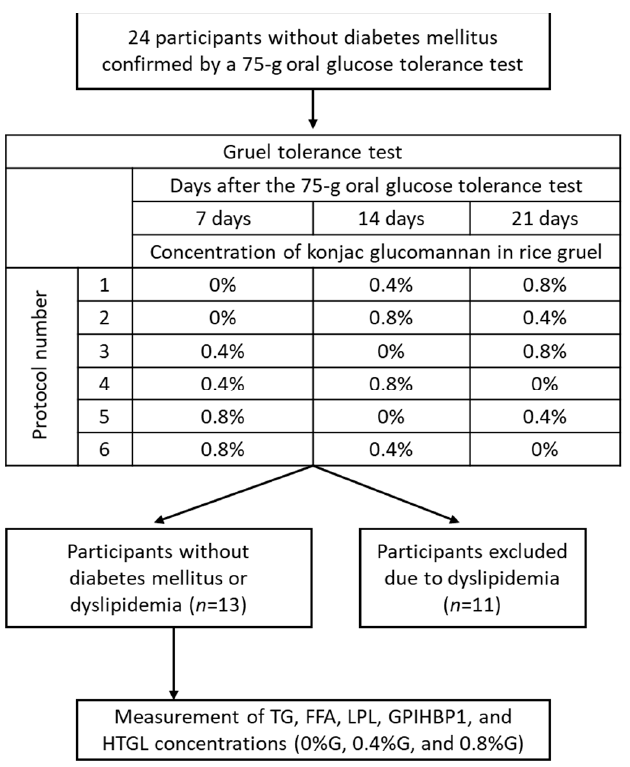
Figure 1. Study design. In total, 24 subjects without a history of diabetes mellitus underwent a gruel tolerance test, which